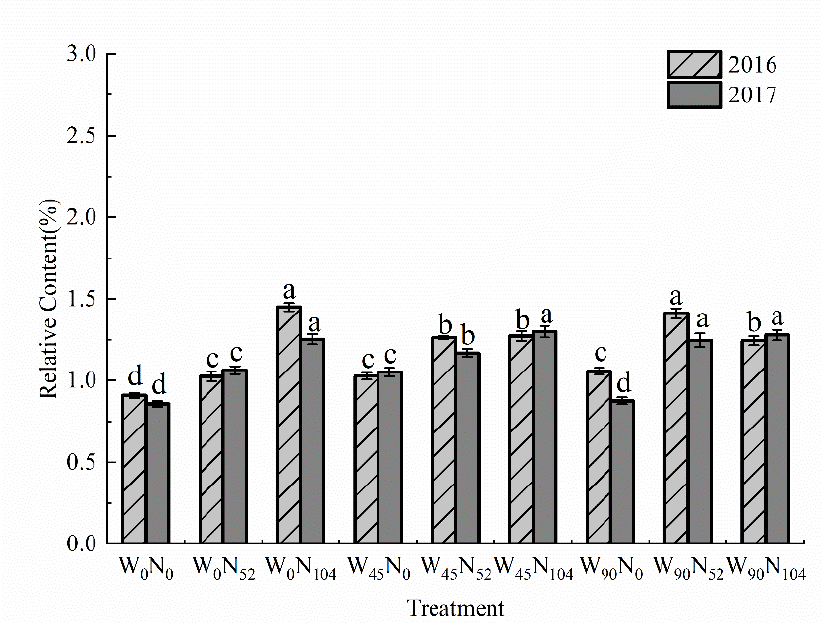
Figure 7. Effects of irrigation, nitrogen, and the interaction between the two on valine content of sunflower seed kernels (mean ± SD; different lowercase letters indicate that there are significant differences in nine treatments at the 5% level in 2016 and 2017, respectively).